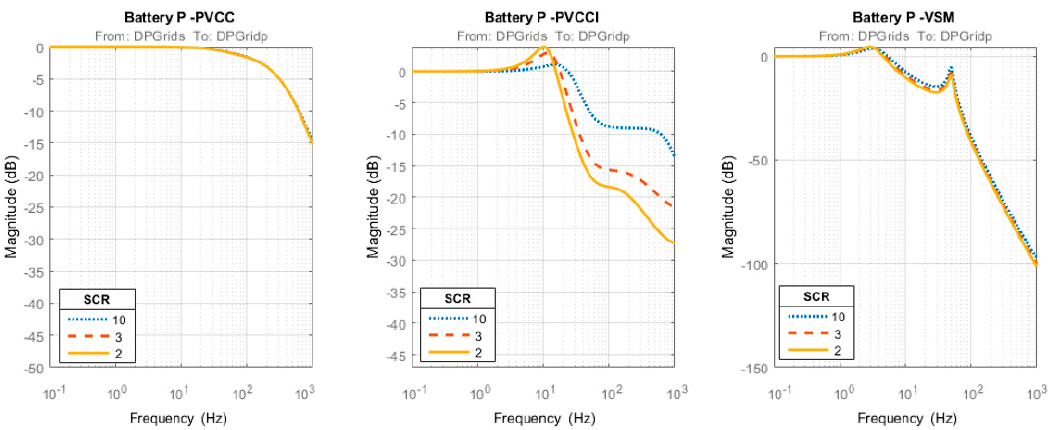
Figure 13. Power responses for the battery-connected controllers for di ff erent (SCRs).